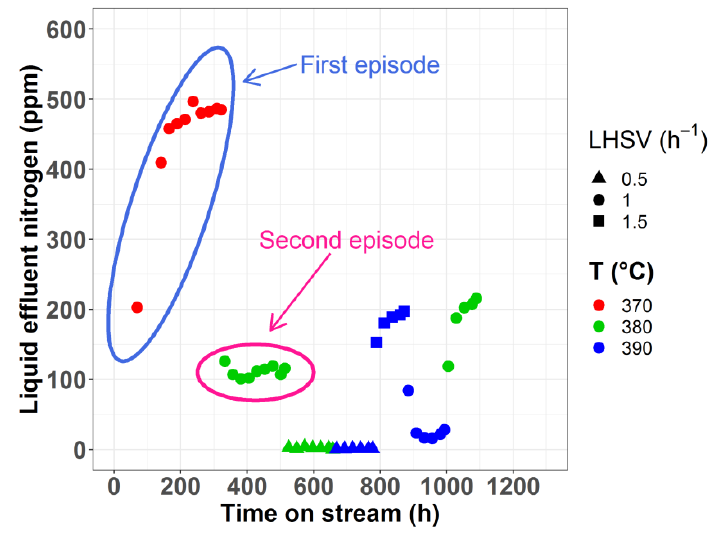
Figure 10. Liquid effluent nitrogen as a function of time on stream (same feedstock, P = 140 bar).